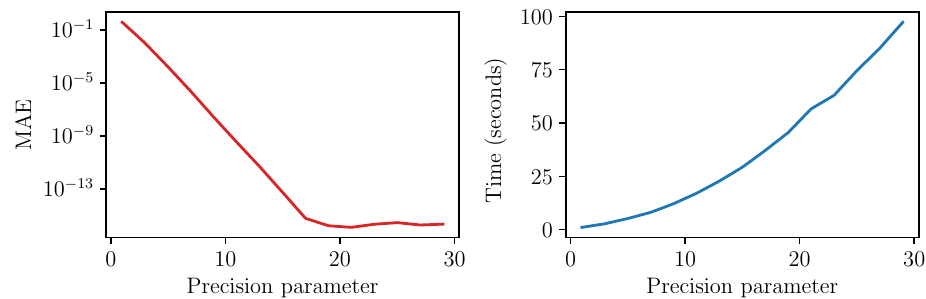
Figure 4. Dependence between the number of terms in the polynomial encoding, the numerical error and the execution time,